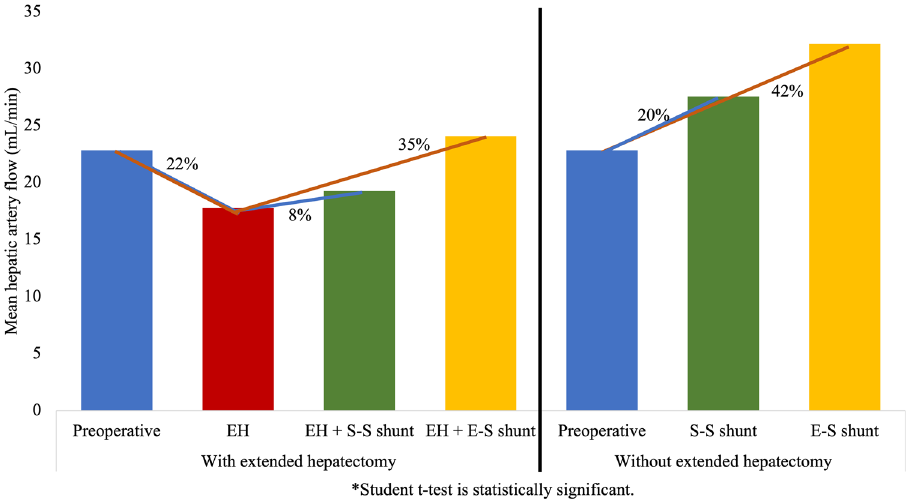
Figure 2. HAF changes with and without EH in three steps without PCS, with side-to-side portocaval shunt (S–S PCS) and with end-to-side portocaval shunt (E–S PCS). (1) EH (75%) reduces the HAF/100 g by 22%; (2) S–S PCS increases the reduced HAF/100 g following EH by 8%; (3) S–S PCS increases the HAF/100 g without EH (20%) more than with EH; (4) The HAF/100 g following EH with an E–S PCS is even higher than the normal HAF/100 g.